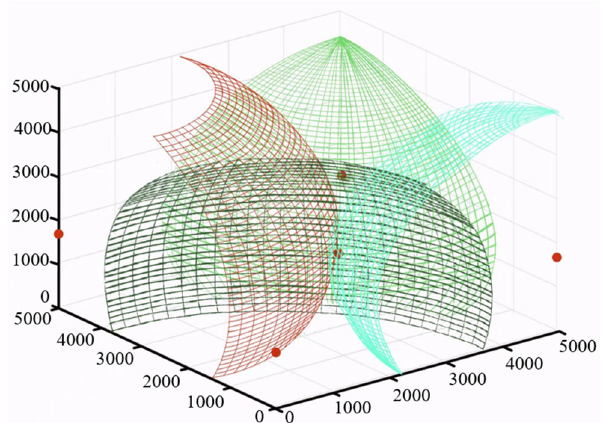
Figure 8. Schematic diagram of normal data measurement error.